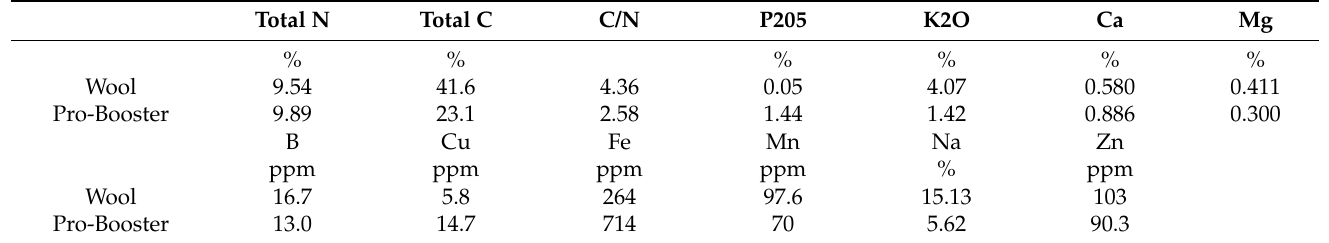
Table 1. Laboratory analysis of two fertilizer products: wool pellets (Wild Valley Farm, Croydem, UT, USA) and Pro-Booster mixed fertilizer blend (North Country Organics, Bradford, VT, USA). Analysis conducted at the University of Maine Analytical Laboratory